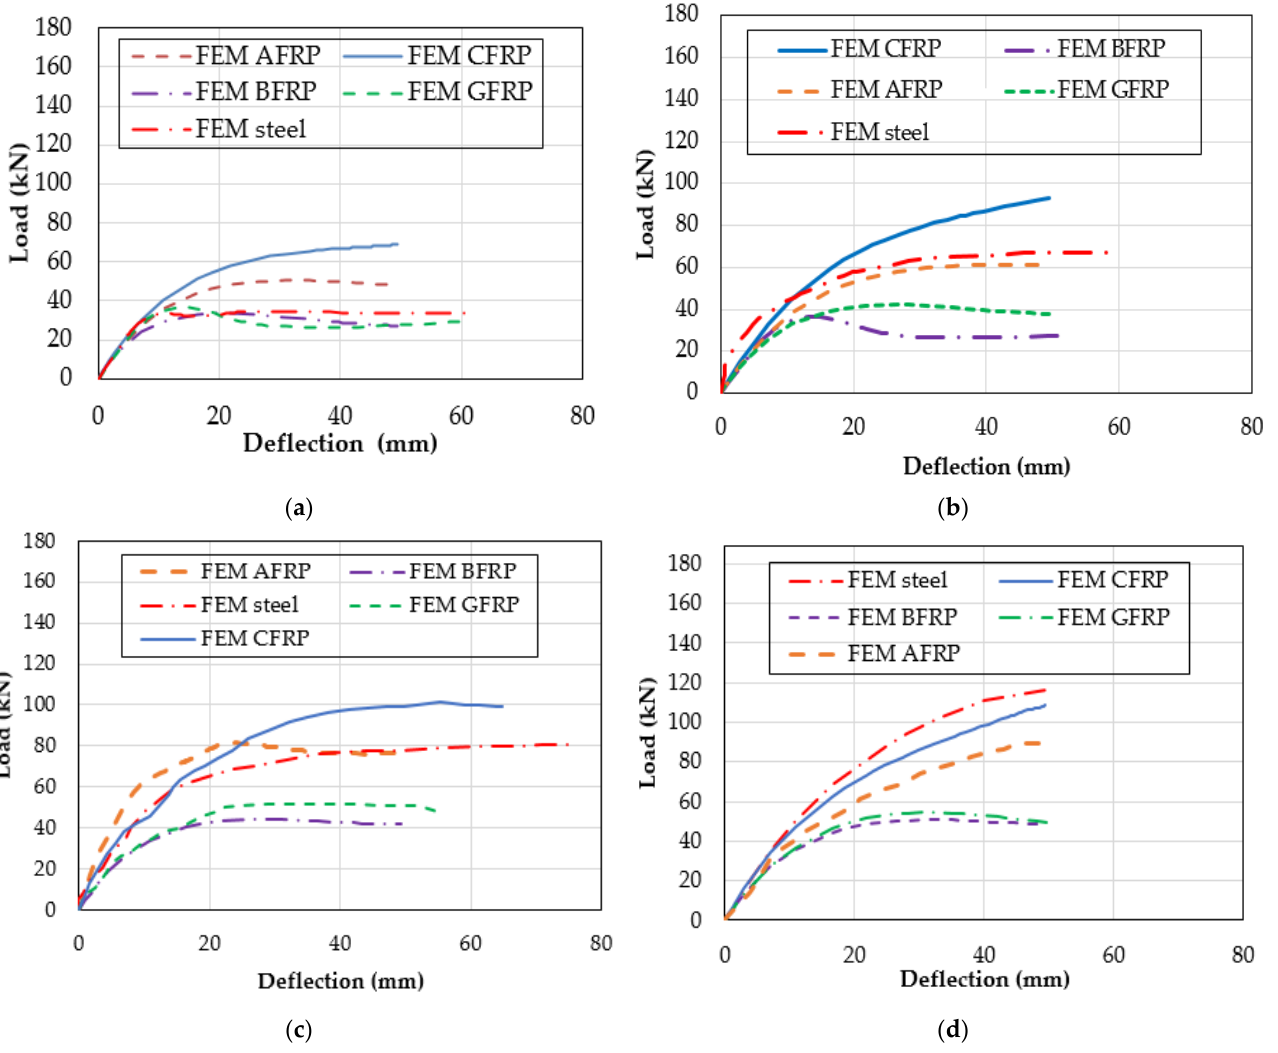
Figure 5. Load Deflection curves for simple beam with different reinforcement ratios: ( a ) 0.15%, ( b ) 0.27%, ( c ) 0.42%, and ( d ) 0.60%.